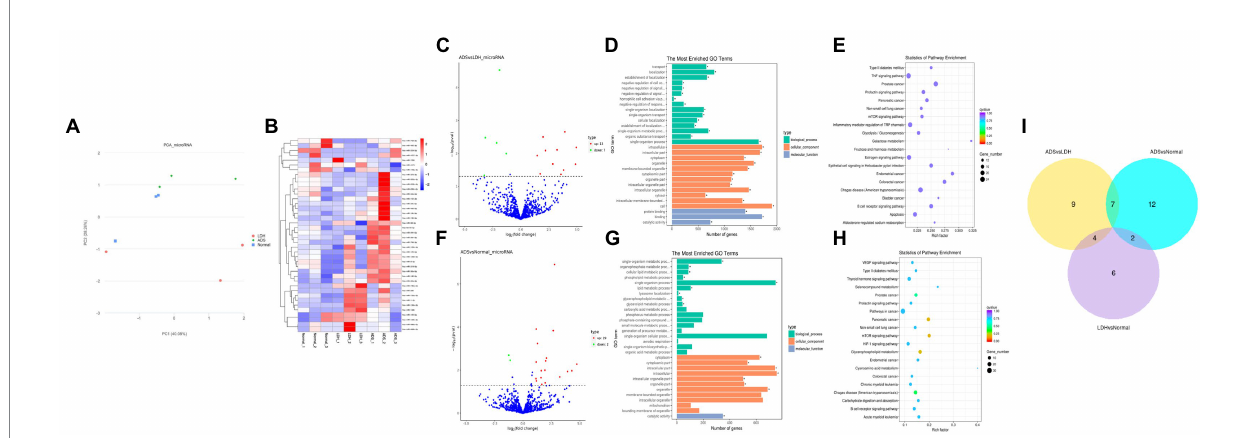
FIGURE 4 Identification of differentially expressed miRNAs in ADS (A) Principal component analysis shows the clustering of miRNA in different samples. (B) Hierarchical clustering illustrates distinguished expression differences of miRNA and between the three groups and homogeneity between groups. (C) Volcano plot showing differentially expressed miRNAs in ADS and LDH group. (D) The 20 most enriched Gene Ontology terms for the parental genes of the differentially expressed miRNAs in ADS and LDH group. (E) The 20 most enriched KEGG pathways for the differentially expressed miRNAs in ADS and LDH group. (F) Volcano plot showing differentially expressed miRNAs in ADS and Normal group. (G) The 20 most enriched Gene Ontology terms for the parental genes of the differentially expressed miRNAs in ADS and Normal group. (H) The 20 most enriched KEGG pathways for the differentially expressed miRNAs in ADS and Normal group. Enriched GO terms are on the vertical axis, and the number of annotated differentially expressed genes associated with each GO term is indicated on the horizontal axis. The size of the symbol represents the number of genes, and the colors represent p -value in KEGG. (I) The Venn diagram created by the differentially expressed data of